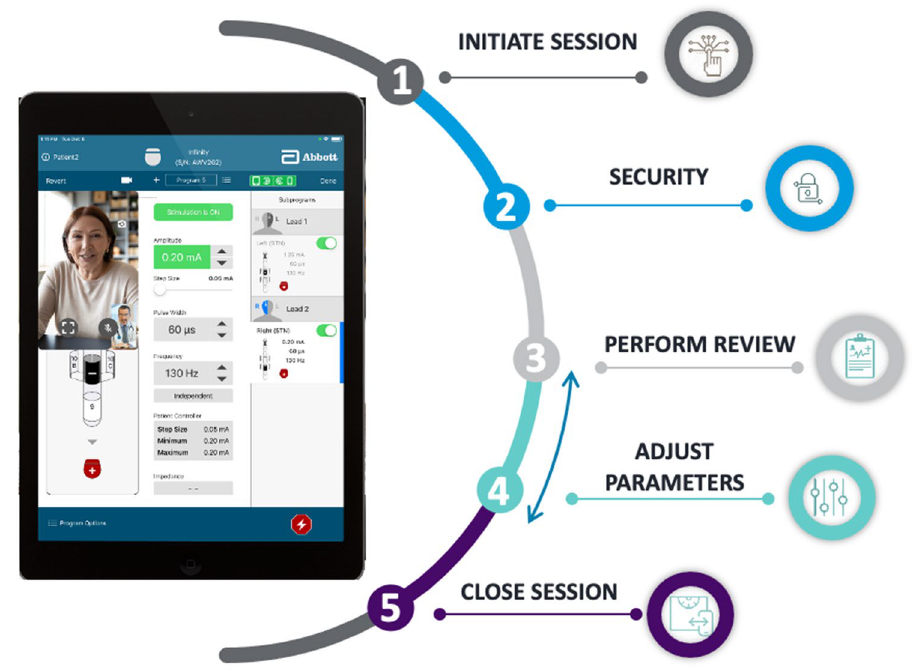
Figure 3. Clinical and communication workflow for a remote session. A typical remote care session using the remote care platform consists of the following steps: (1) session is initiated by the subject, (2) authentication of users and devices enabled via secure connection through the backend server, (3) review of symptoms and performance by the clinician, (4) iterative adjustment of programming parameters including amplitude, pulse width, frequency, and contact selection, (5) settings are saved, and session is closed by the clinician. *Individuals portrayed in the figure are not actual patients. Images are representative and taken from stock photos